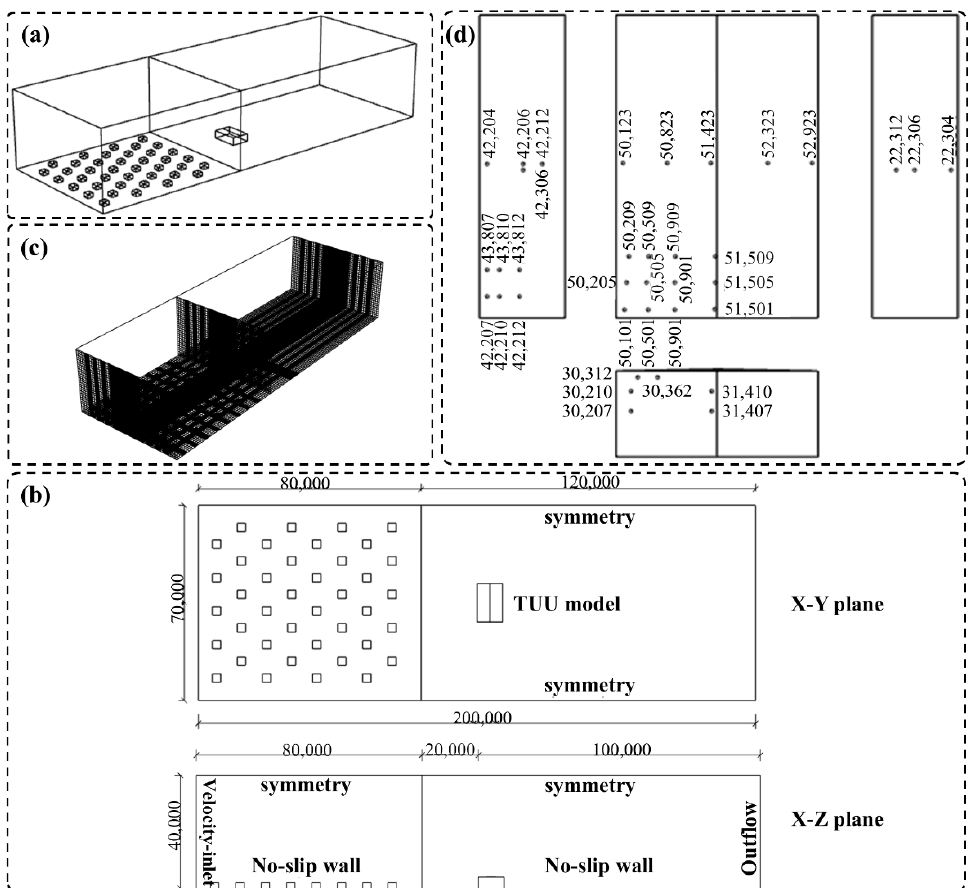
Figure 4. Calculation domain and measurement point arrangement for numerical simulation: ( a ) overall view; ( b ) XY and XZ plane; ( c ) watershed grid distribution; ( d ) arrangement of measurement points at the standard height of the TTU model.